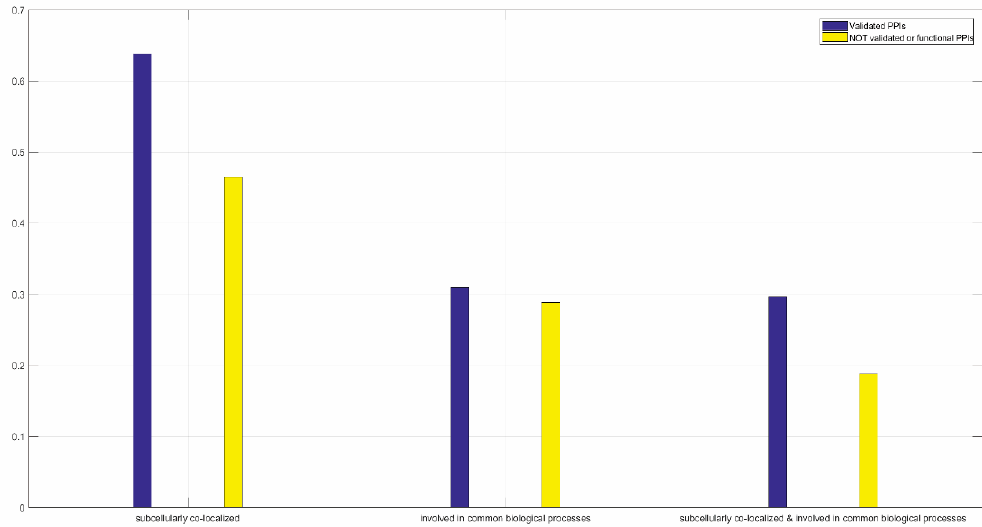
Figure 3. Statistical analyses of subcellular co-localization and involvement in common biological processes of the partners that are validated and NOT validated to interact with the protein YBX2. The PPIs are extracted via the evidence of co-expression in STRING.